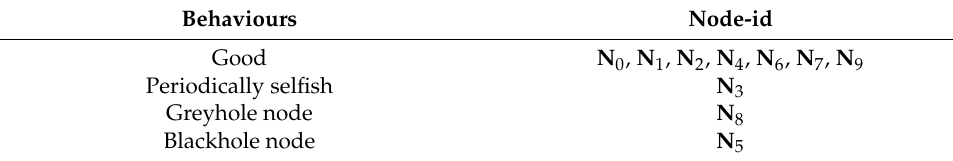
Figure 6. Reputation values for a good node ( N 0 ) calculated by periodically selfish node ( N 3 ). Table 4. Behaviours displayed by the various